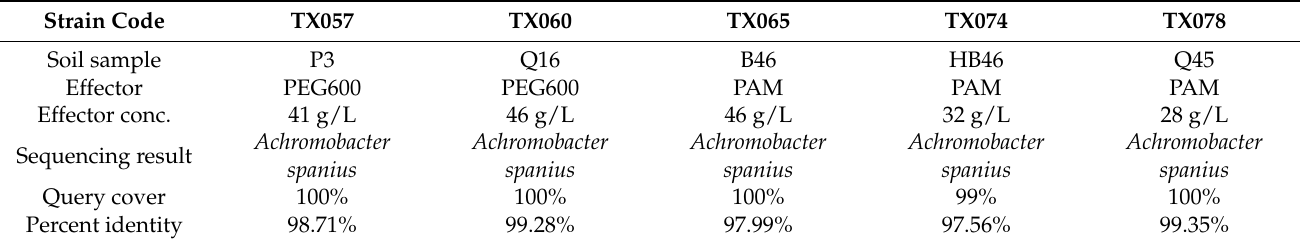
Table 4. Overview of obtained A. spanius strains using droplet-based microfluid